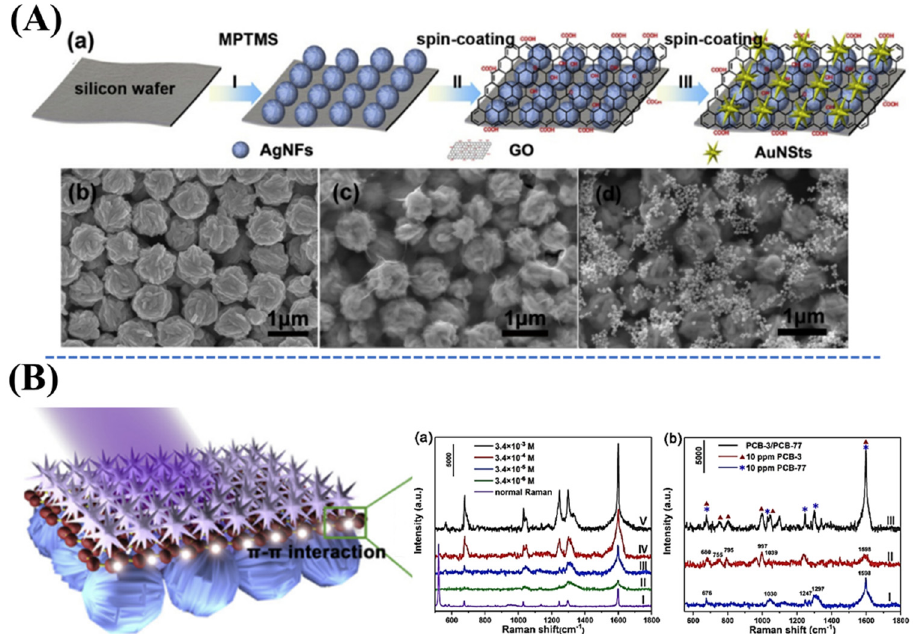
Figure 6. ( A – a ) Schematic demonstration of the fabrication process for a novel hybrid nanomaterial as well as Au nanostars–GO–flower-inspired Ag nanoparticles (AuNSts-GO-AgNFs) for ultra-sensitive SERS detection of PCBs. SEM images of ( A – b ) AgNFs, ( A – c ) AgNFs-GO, and ( A – d ) AgNFs-GO-AuNSts. ( B – a ) Normal Raman spectrum and SERS spectra of PCB-77 on this substrate with different concentrations. ( B – b ) Compared SERS spectroscopy of PCB-77, PCB-3, and PCB-3/PCB-77 mixture. Adapted from [38].